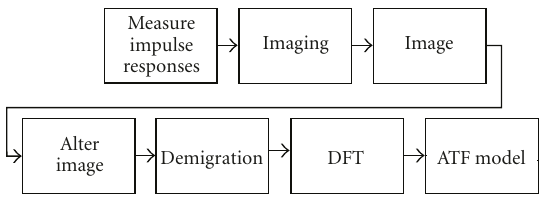
Figure 4: Block diagram of the processing from the acoustic image to the ATF